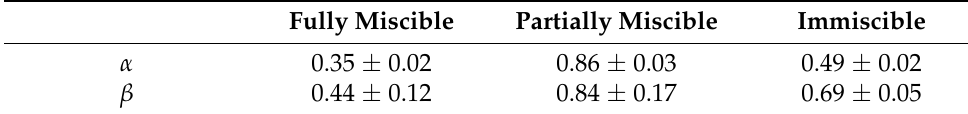
Table 2. Summary of steady values of 𝛼 and 𝛽 for the three experiments.